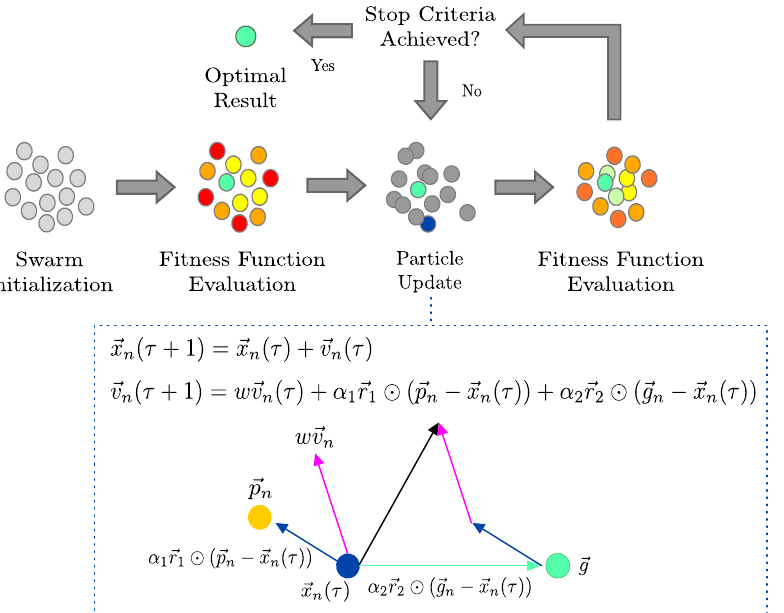
Figure 4. Illustrative procedure of Particle Swarm